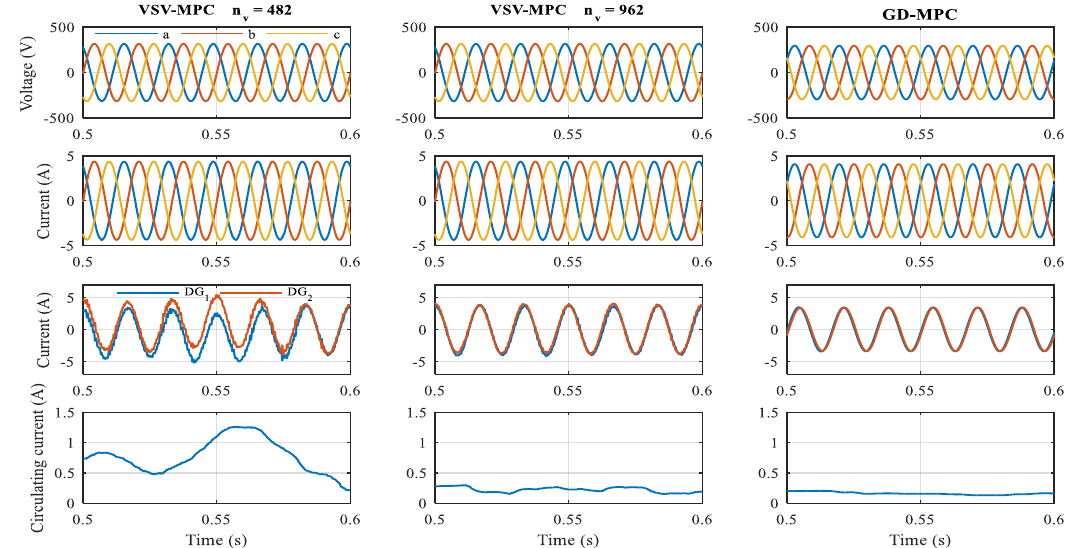
Figure 12. Control performance of the proposed GD-MPC and VSV-MPC in the MG system with two parallel inverters.